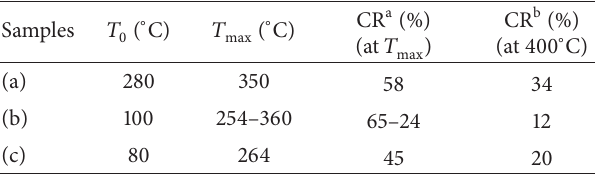
Table 2: Thermal characteristics of samples kraft cellulose (a), p - nitrobenzoyl chloride (b), and cellulose p -nitrobenzoate (c).